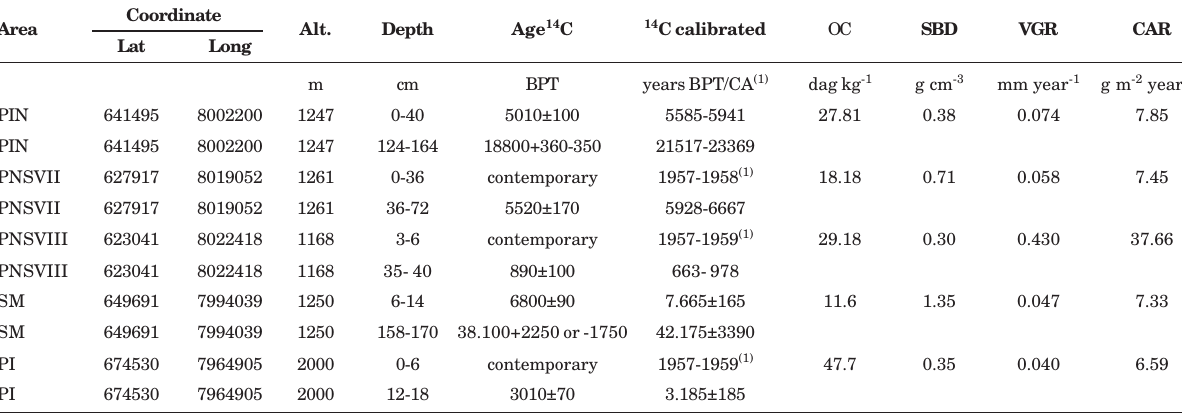
SD: Standard Deviation; UF: Unrubbed Fiber; RF: Rubbed Fiber; von Post: von Post decomposition scale; SBD: Soil Bulk Density; OMD: Organic Matter Density; OM: Organic Matter; MM: Mineral Material; GM: Gravimetric Moisture; MR: Minimal Residue; OC: Organic Carbon. Table 2. Rates of vertical growth and carbon accumulation of peatland profiles of the